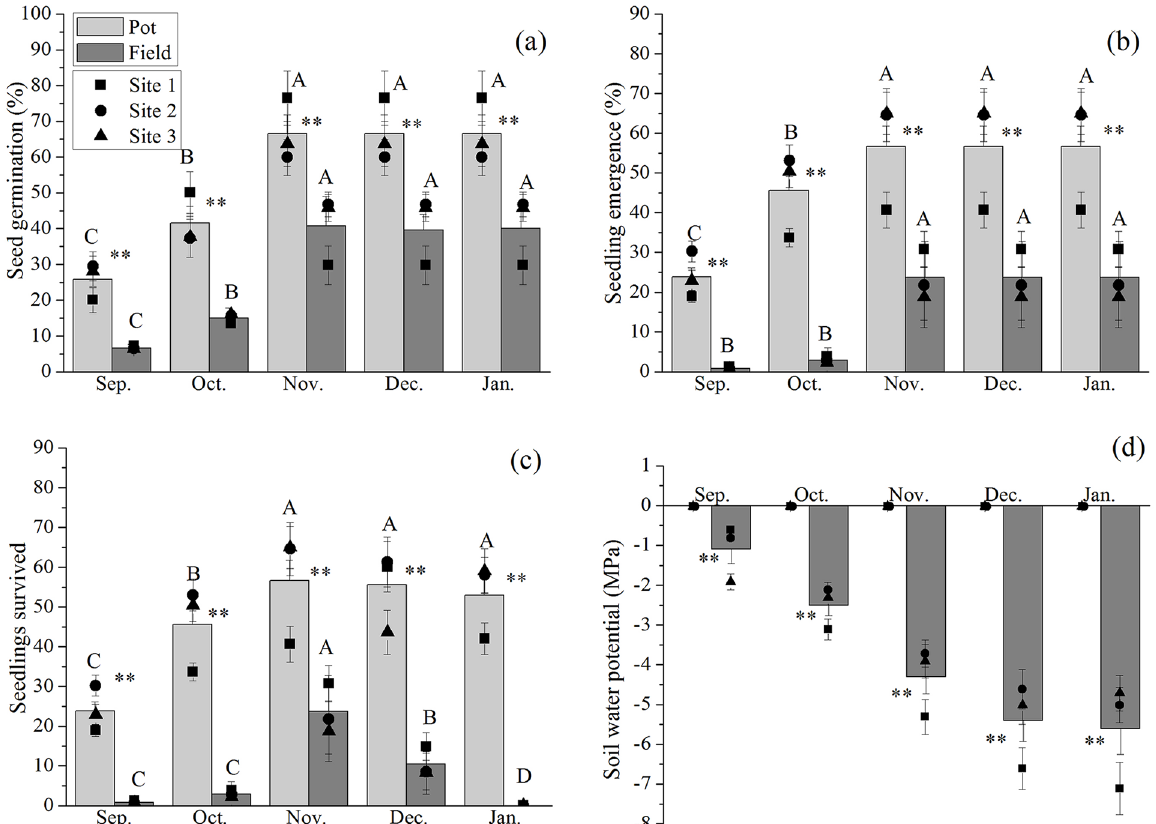
Fig 1. Seed germination(a), seedlingemergence (b), seedlingsurvived (c) and soil water potential (d) for Nyssa yunnanensis in pots with sufficient moisture, and in field with natural moisture at three sites duringthe entire seedlingestablishment period. Squares, circles and trianglesrepresent site means; values are means ± SD; ** indicatesa significant difference betweentreatments in “Pot” and “Field” at P < 0.01; For the soil with sufficient moisture (Pot) or natural moisture (Field), means with different uppercase are significantly different from September to January at P <